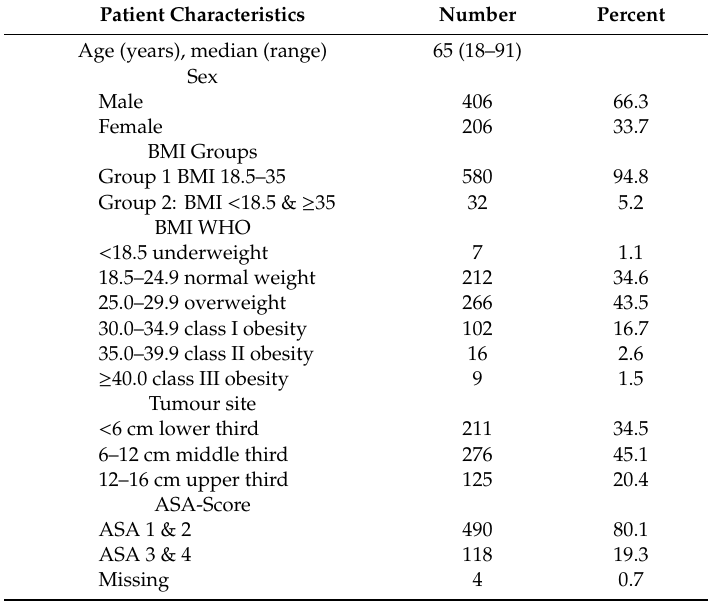
Table 1. Demographics, tumour and treatment characteristics of 612